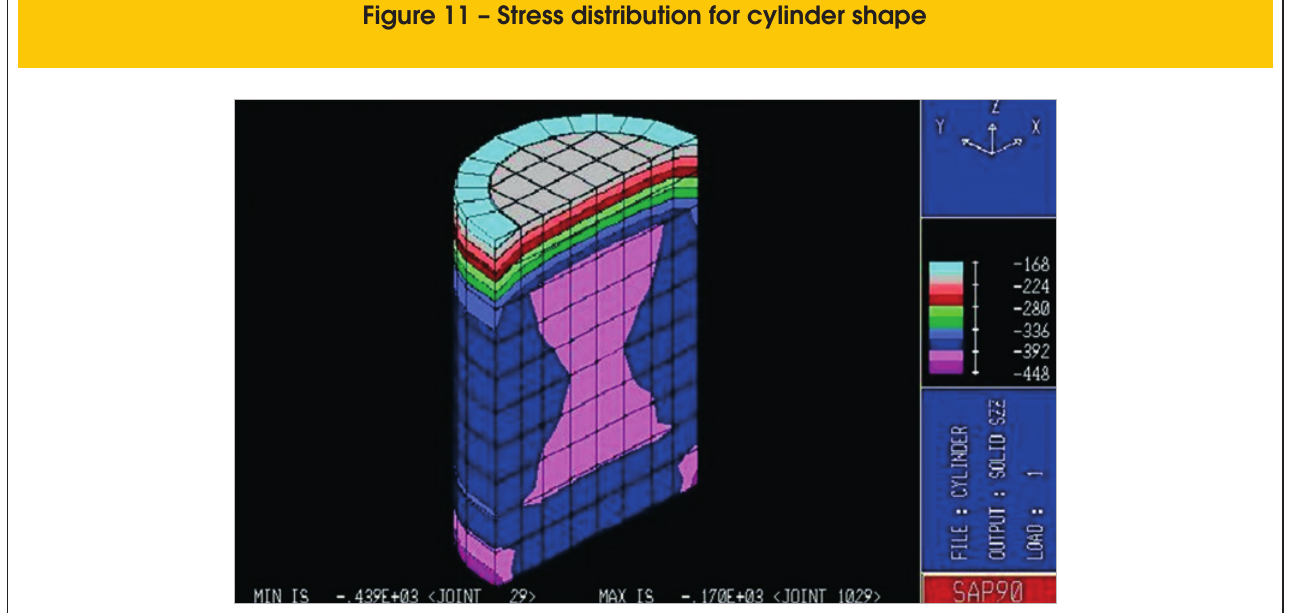
Figure 11 – Stress distribution for cylinder shape